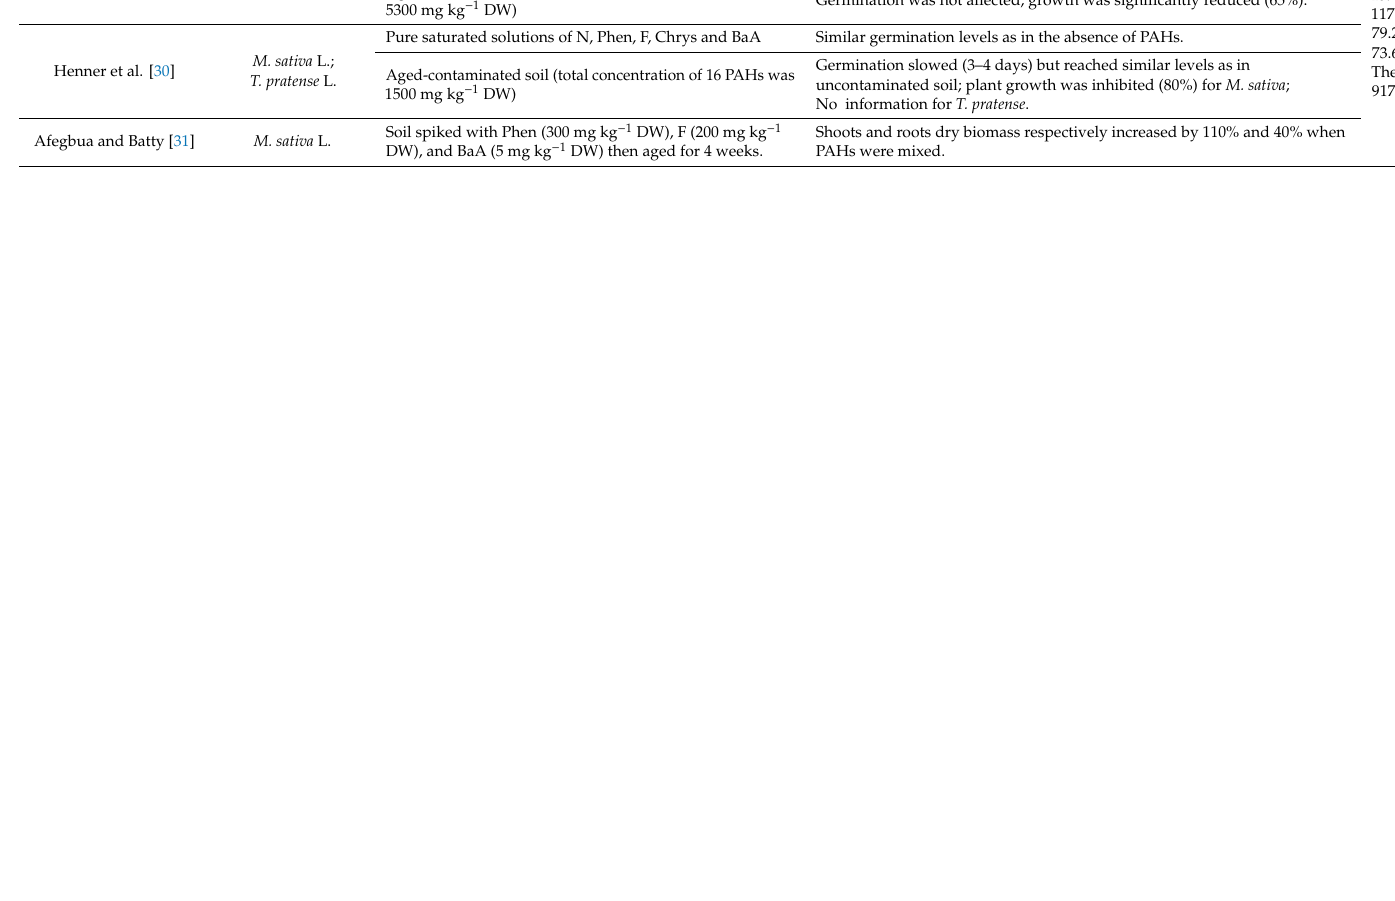
Germination / Growing Conditions in Presented Experimental Soil (Table